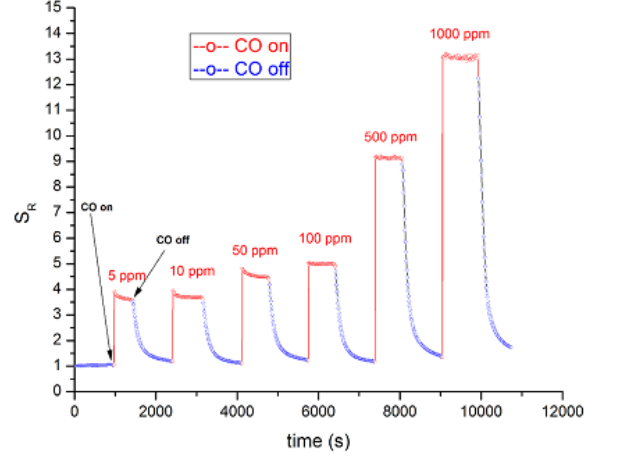
Figure 15. The response-recovery characteristics of the 50% SnO 2 -50% ZnO sensor at T w = 500 °C, from ref. [69].